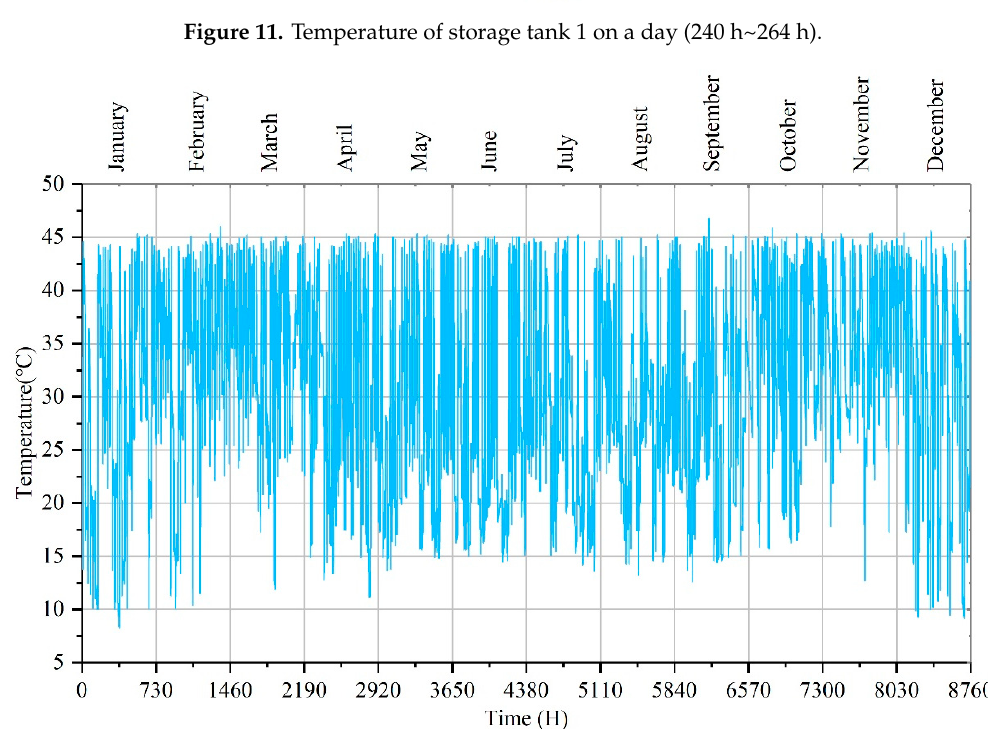
Figure 12. Temperature of storage tank 1 for one year.